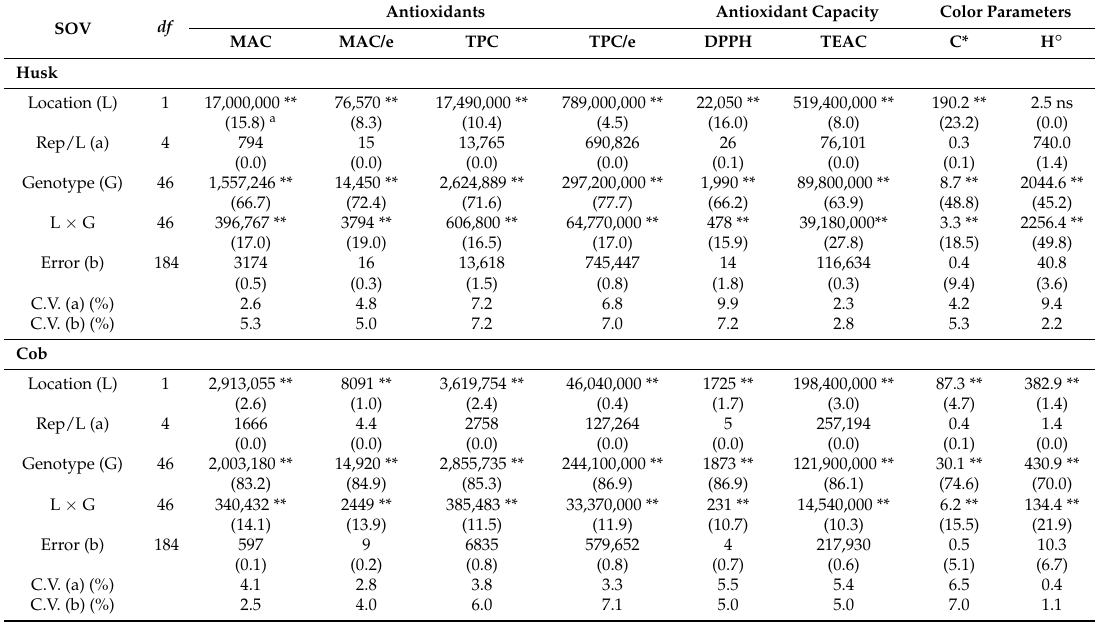
Table 2. Mean squares and significance of effects for monomeric anthocyanin content (MAC), total phenolic content (TPC), and antioxidant activity determined by DPPH method and TEAC method and color parameters, in husk and cob of 1–47 genotypes evaluated in the dry season across Uthai Thani and Khon Kaen